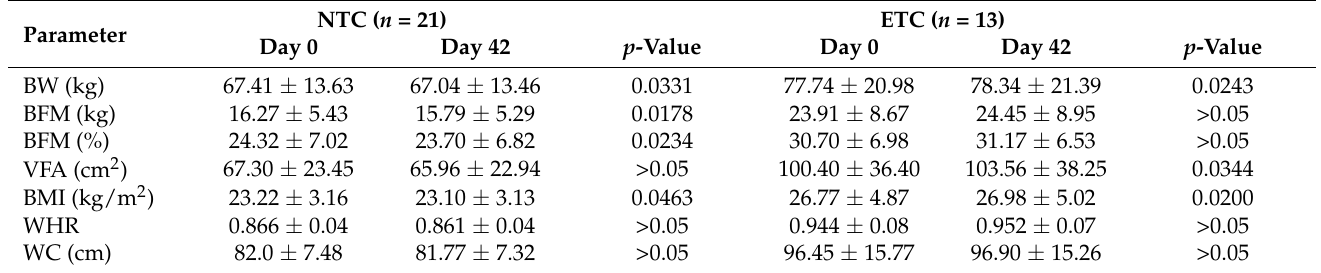
Table 3. Anthropometric characteristics of the subjects before and after apricot seeds